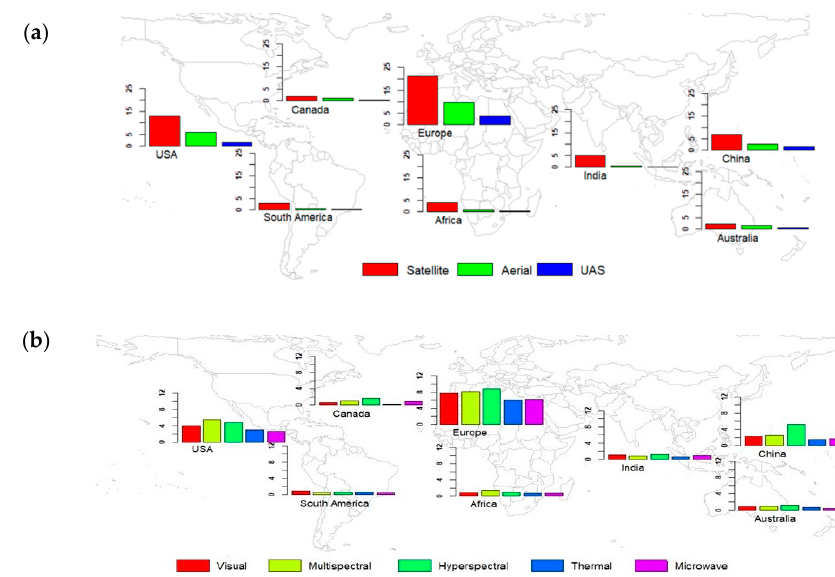
Figure 3. Summary of agricultural remote sensing studies for major geographic regions by platform ( a ) and sensor ( b ) type. Note: Y axis represents percentage, which was calculated by comparing the number of papers by category in each region to the total papers.